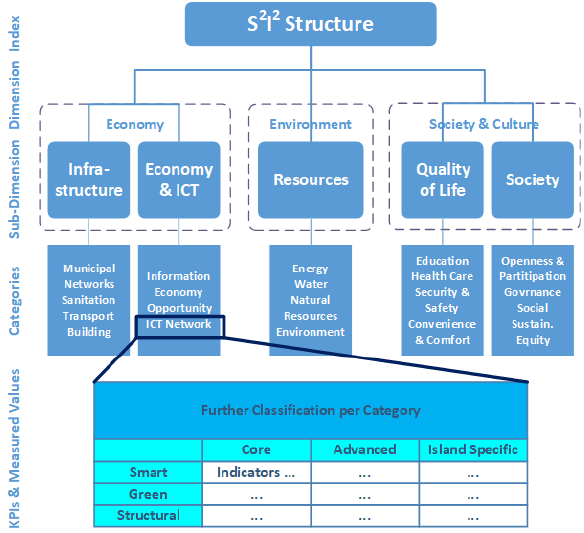
Figure 2. The proposed S 2 I 2 Index